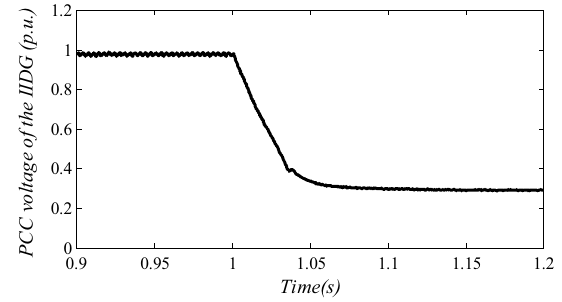
Fig. 5 PCC voltage of the IIDG